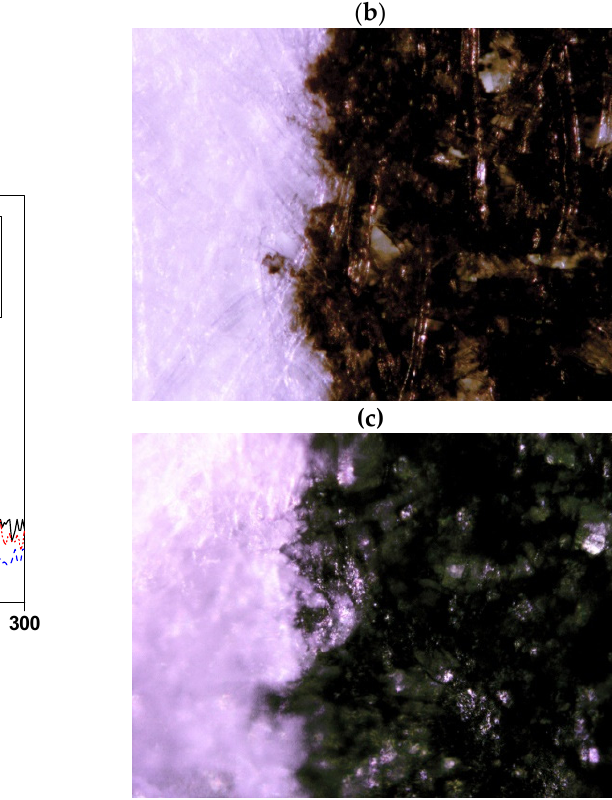
Figure 11. Print quality assessment: ( a ) comparison of print quality based on changes in the RGB green channel value of the samples and images from an optical microscope of the print on ( b ) commercial printer paper and ( c ) refined paper with 20% PAN–PDA fibres; ×10 magnification.